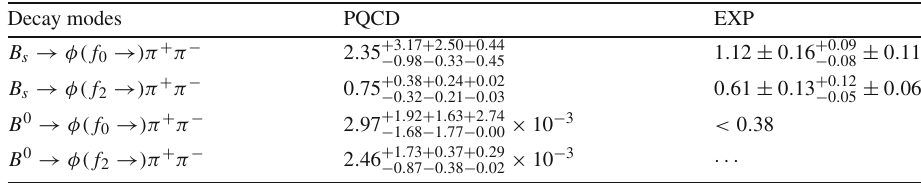
asymmetries parameters and the fractions of longitudinal polarization of final states (in %) of B d , s → φ( f 0 / f 2 → )π + π − decays in PQCD approach